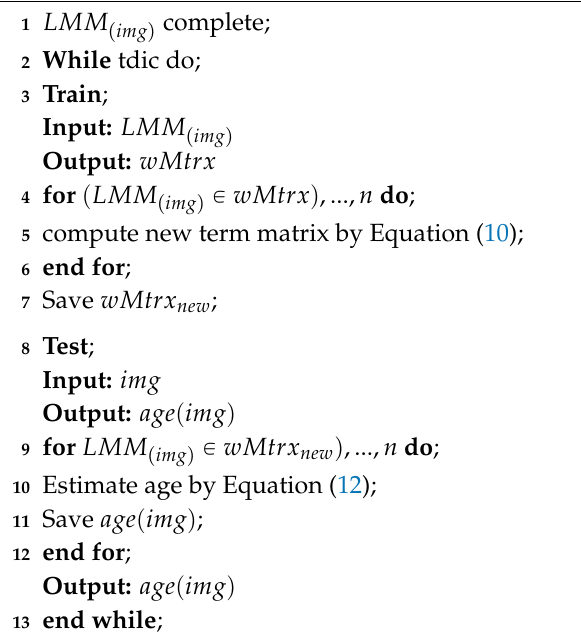
Algorithm 1: The LaGMO age estimation